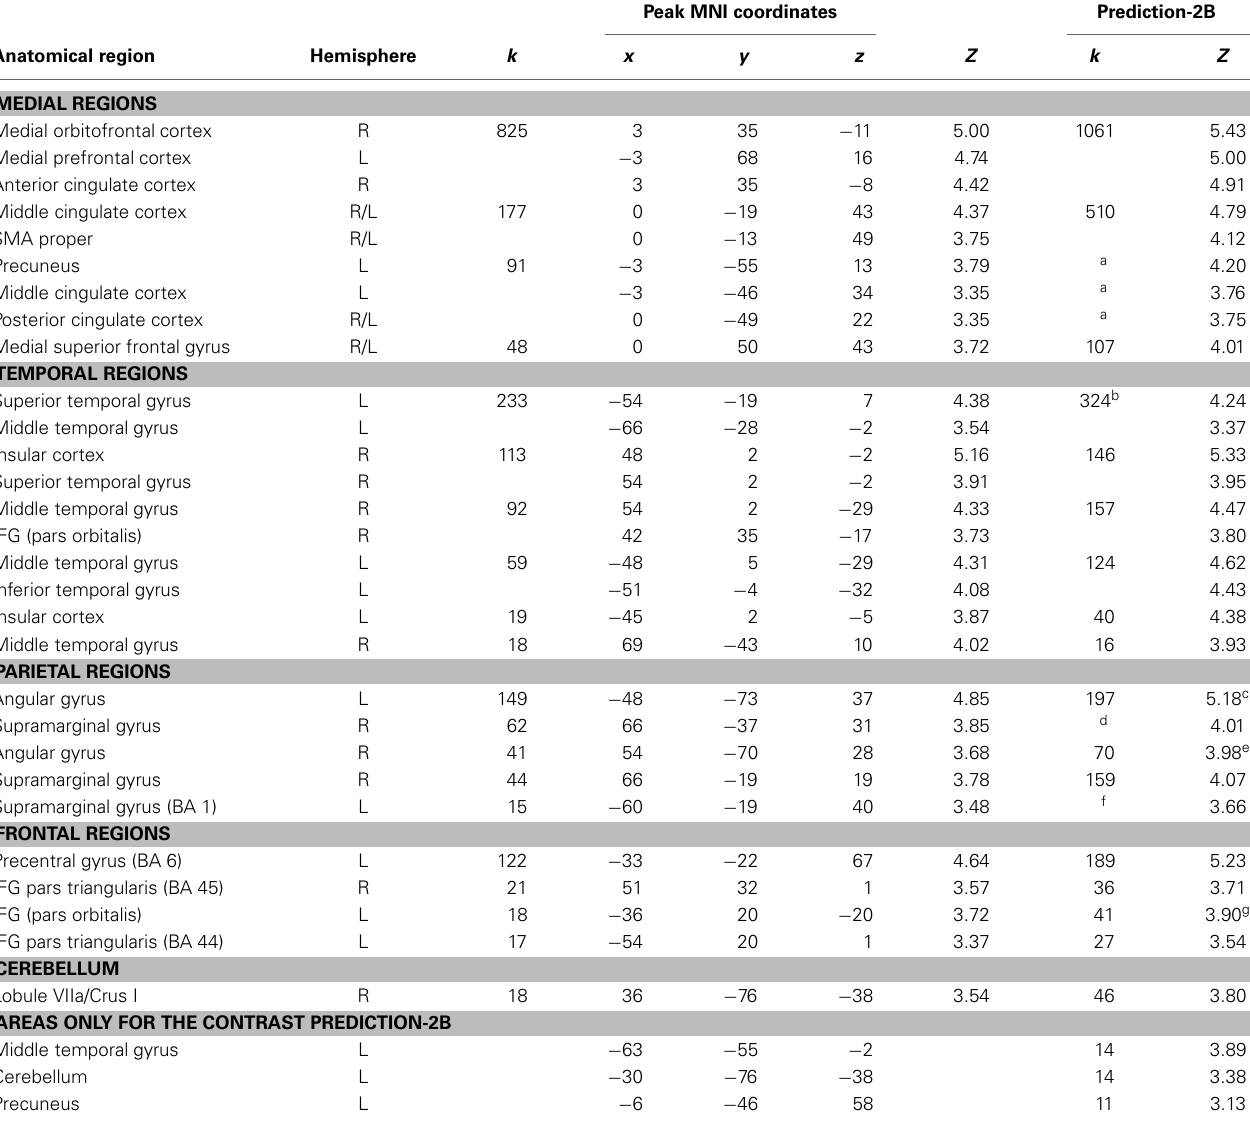
Table 2 | Peak voxels of brain areas that covary positively with the degree of prediction during sensorimotor